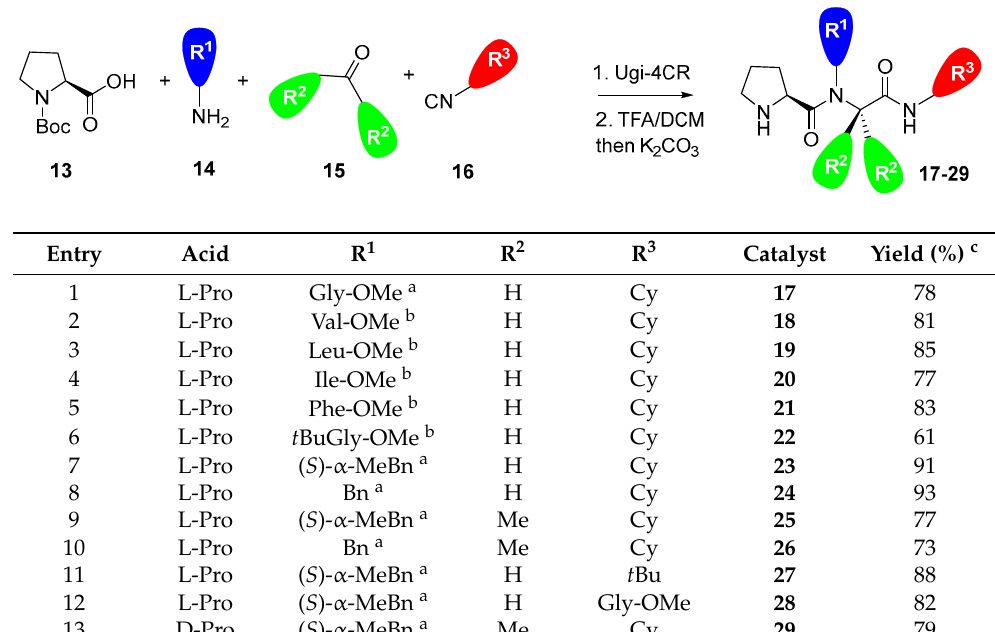
Table 3. Novel library of prolyl peptide–peptoid catalysts.